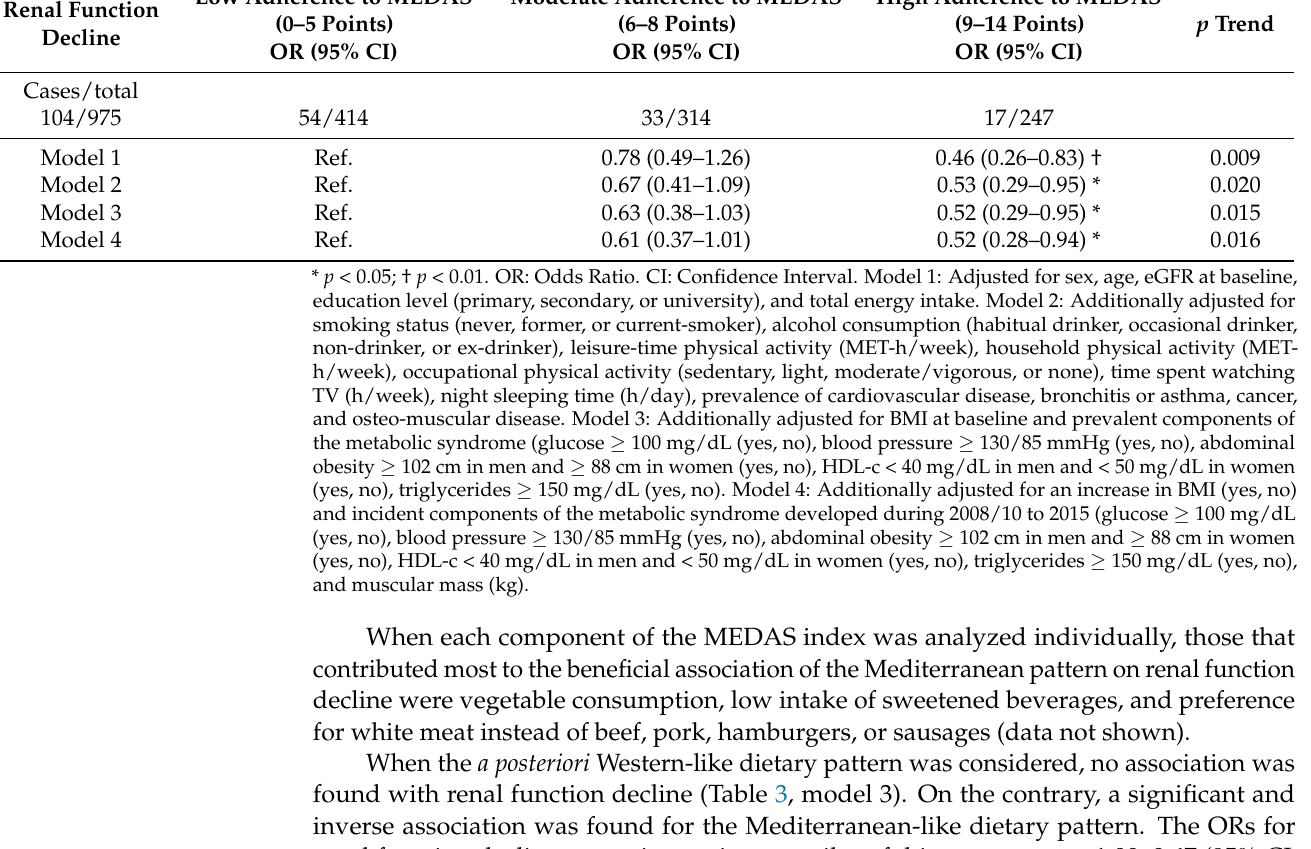
No Renal Function Decline